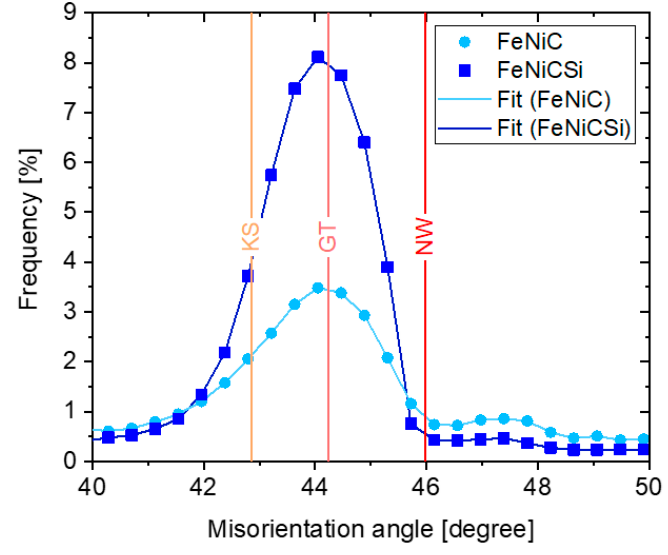
Figure 7. Misorientation angle distribution for FeNiC and FeNiCSi.